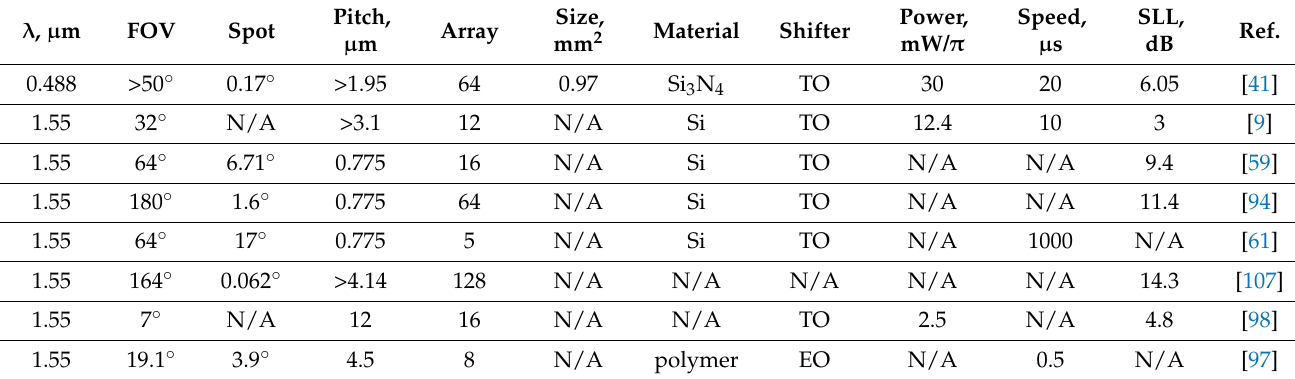
Table 1. Main evaluation parameters of some EF